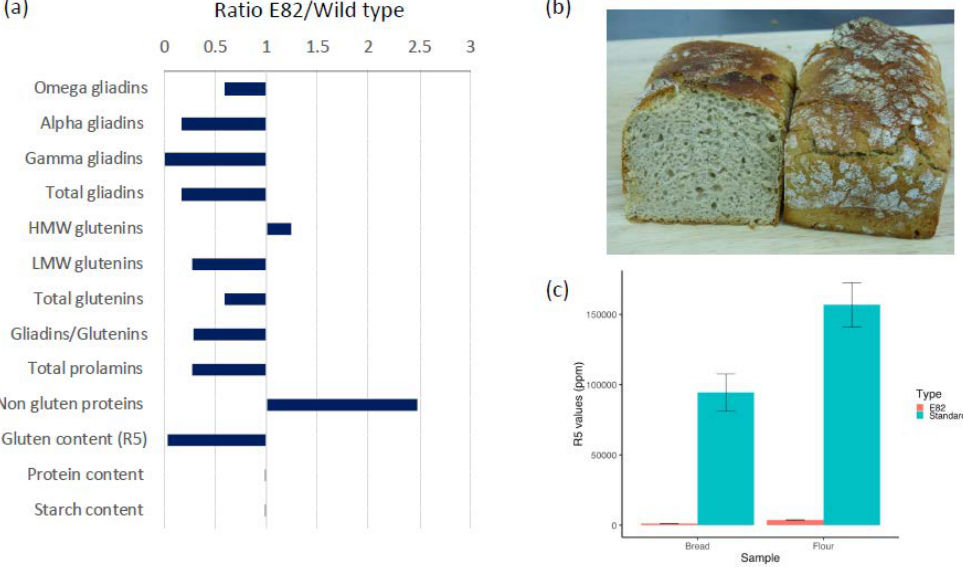
Figure 1. Low-gliadin E82 bread characteristics: ( a ) E82/wild type ratio for main grain components; ( b ) low-gliadin breads used for the dietary intervention, and ( c ) gluten content values (ppm) as determined using the monoclonal antibody R5 for E82 and standard flours and breads . Bread derived from the low-gliadin line E82 was made using a simple formulation with no additives and long fermentation times. The final bread product (Figure 1b) was provided frozen to subjects with specific instructions for defrosting before consumption. The analysis of gluten content (ppm) in the flour and bread by competitive ELISA using the R5 monoclonal antibody showed a significant reduction in the levels of gluten after the fermentation and baking of flour to bread. The content of gluten in flour was 3,545 ppm (mean value), while in bread it was 1,130 ppm (mean value), which was more than three times less (Figure 1c). The gluten content (ppm) of standard flour and bread, made in the same bakery, were 166,400 and 93,966 ppm, respectively [33], which were much higher than that of the E82 line reported here